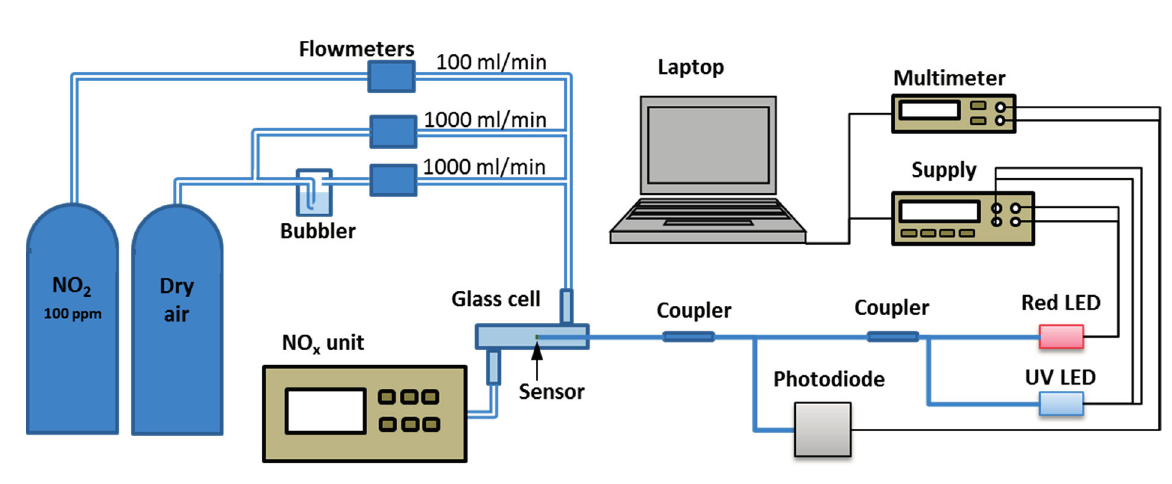
Figure 3. Experimental setup for NO 2